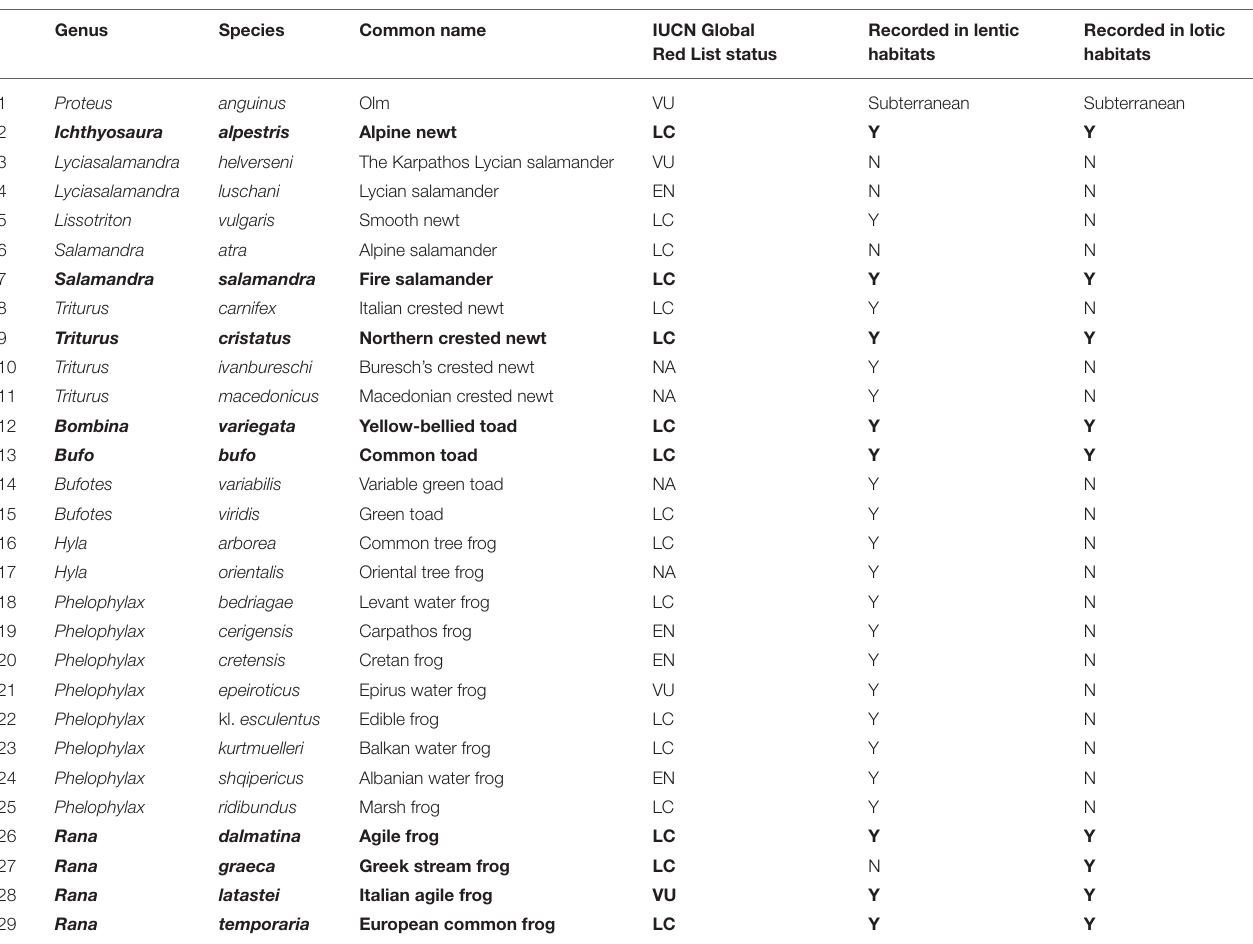
TABLE 1 | List of amphibian species inhabiting hilly/mountain areas of the Balkan